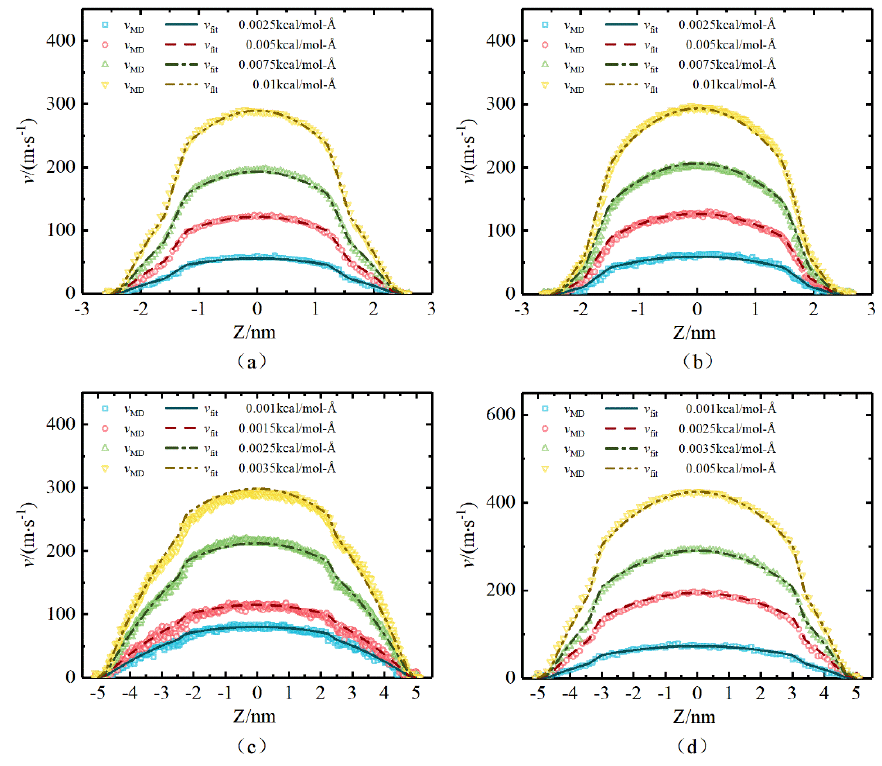
Figure 13. The comparisons of fluid velocity profiles in quartz nanopores calculated by “apparent viscosity” model with molecular simulation data : ( a ) 5 nm pore with OMP = 50%; ( b ) 5 nm pore with OMP = 60%; ( c ) 10 nm pore with OMP = 40%; ( d ) 10 nm pore with OMP = 60%. OMP = 60%; ( c ) 10 nm pore with OMP = 40%; ( d ) 10 nm pore with OMP =